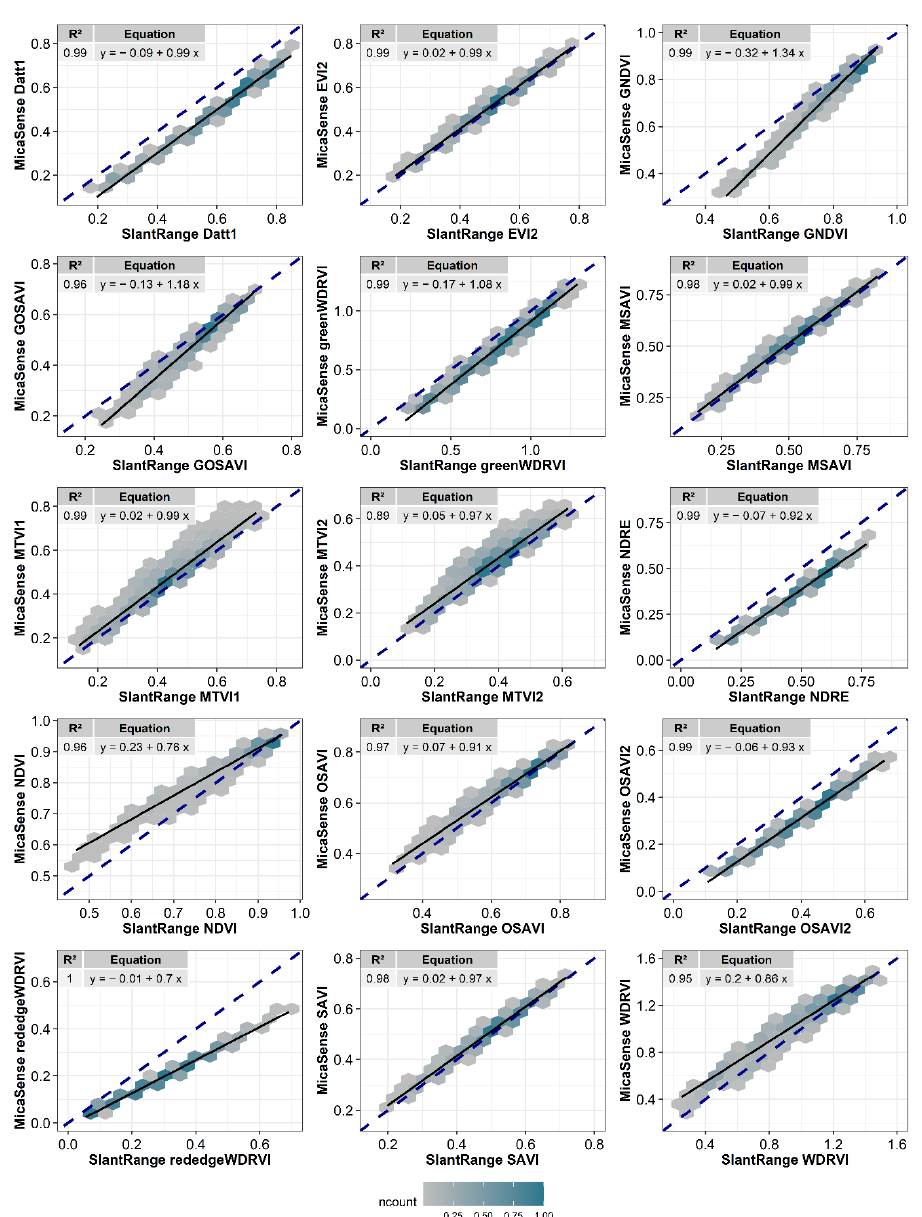
Figure 2. Linear regressions of each VI simulated by the PROSAIL model, between the two sensors (MicaSense and SlantRange). The color code represents the point count distribution scaled to maxi- mum of 1 in each hexagon. The blue dashed line represents the 1:1 relationship and the black line represents the linear regression.